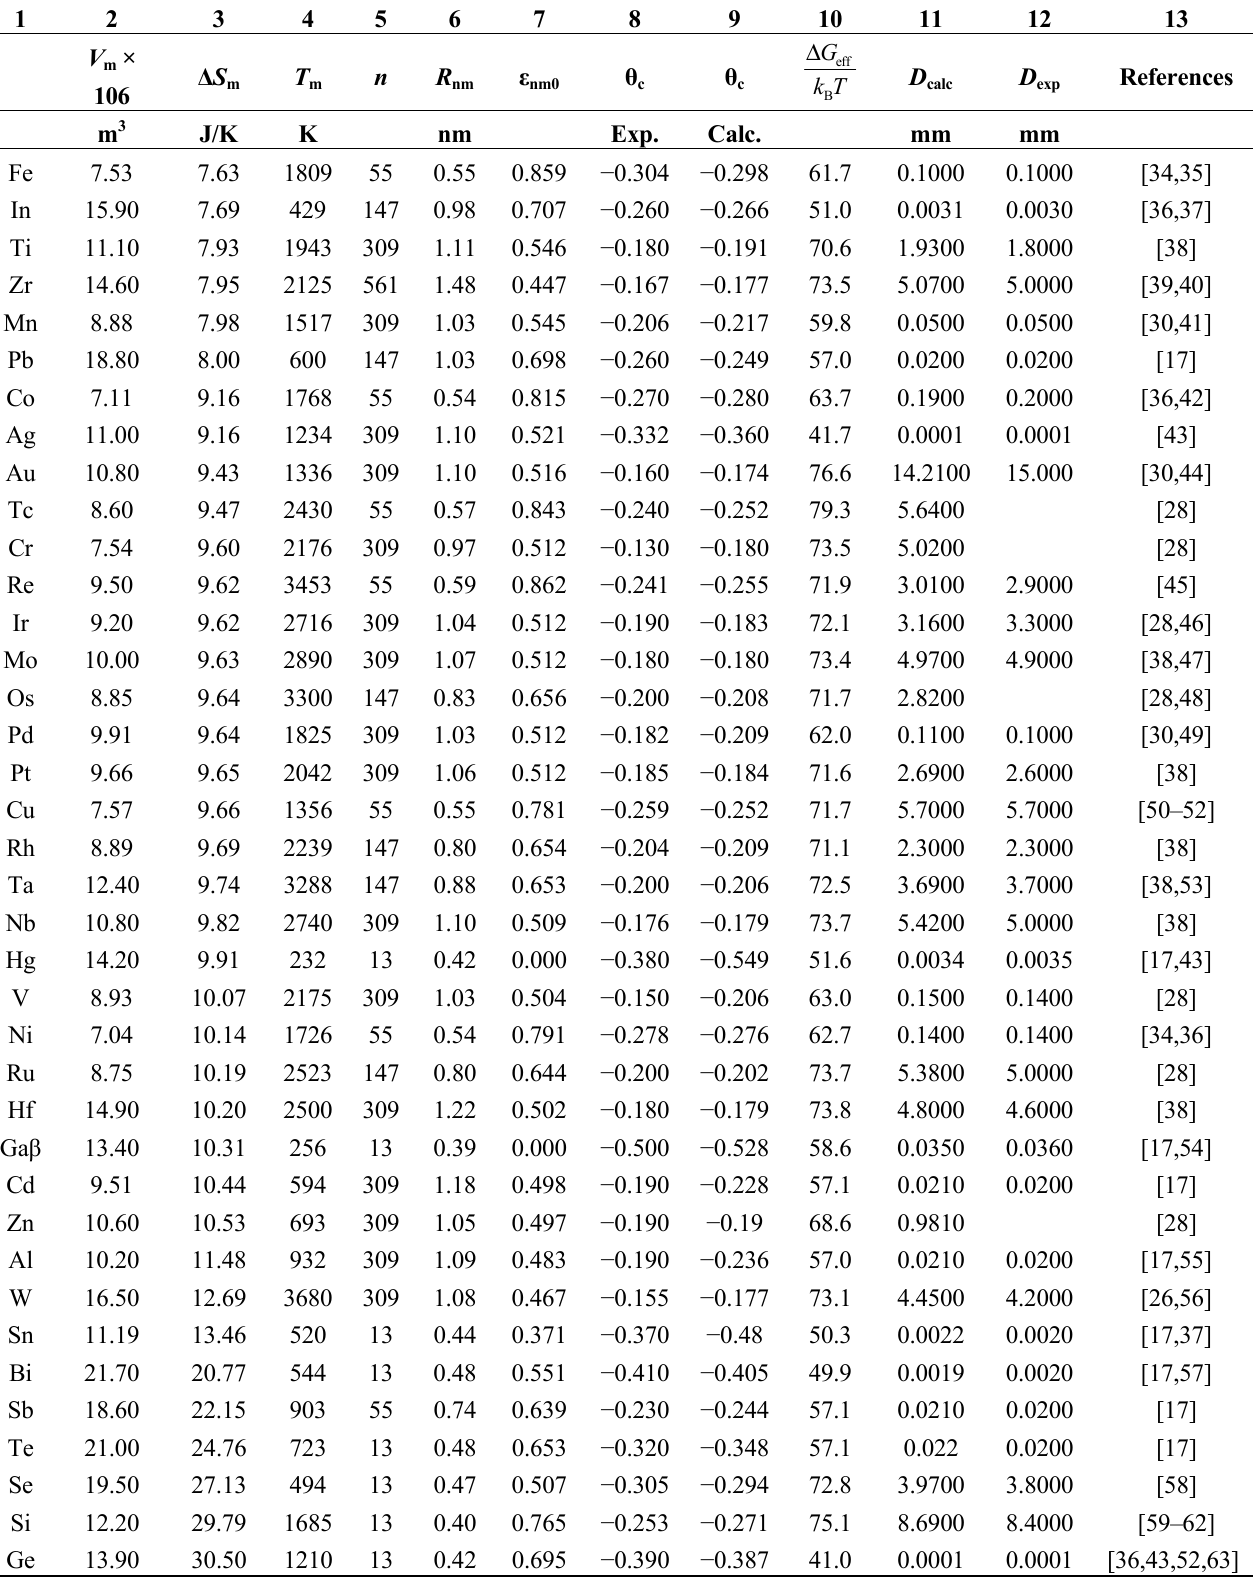
Table 1. Reduced crystallization temperatures of 38 supercooled liquid elements induced by condensed superclusters containing n = 13, 55, 147, 309 or 561